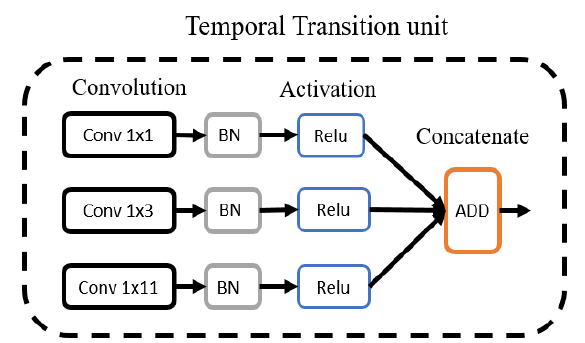
Figure 4. Temporal transition